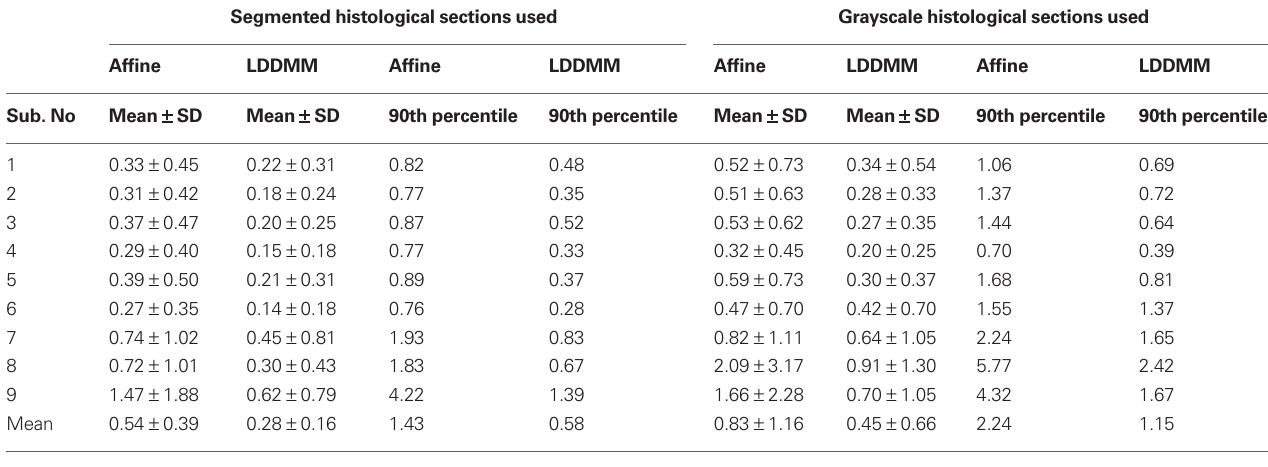
Table 3 | WM/gM surface distance errors (mm).